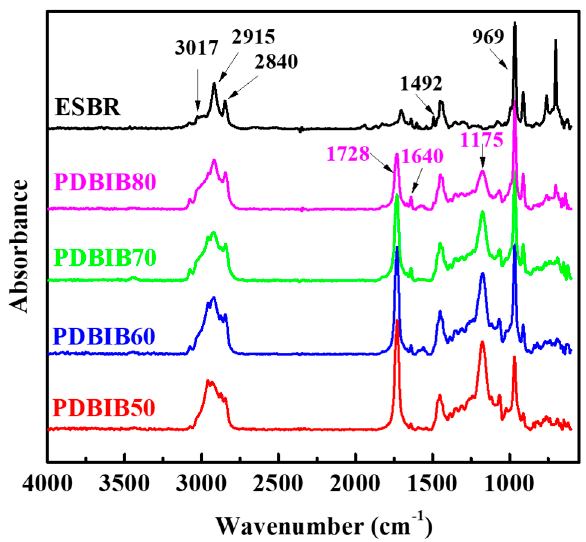
Figure 1. FTIR spectra of PDBIB with different butadiene contents and ESBR.